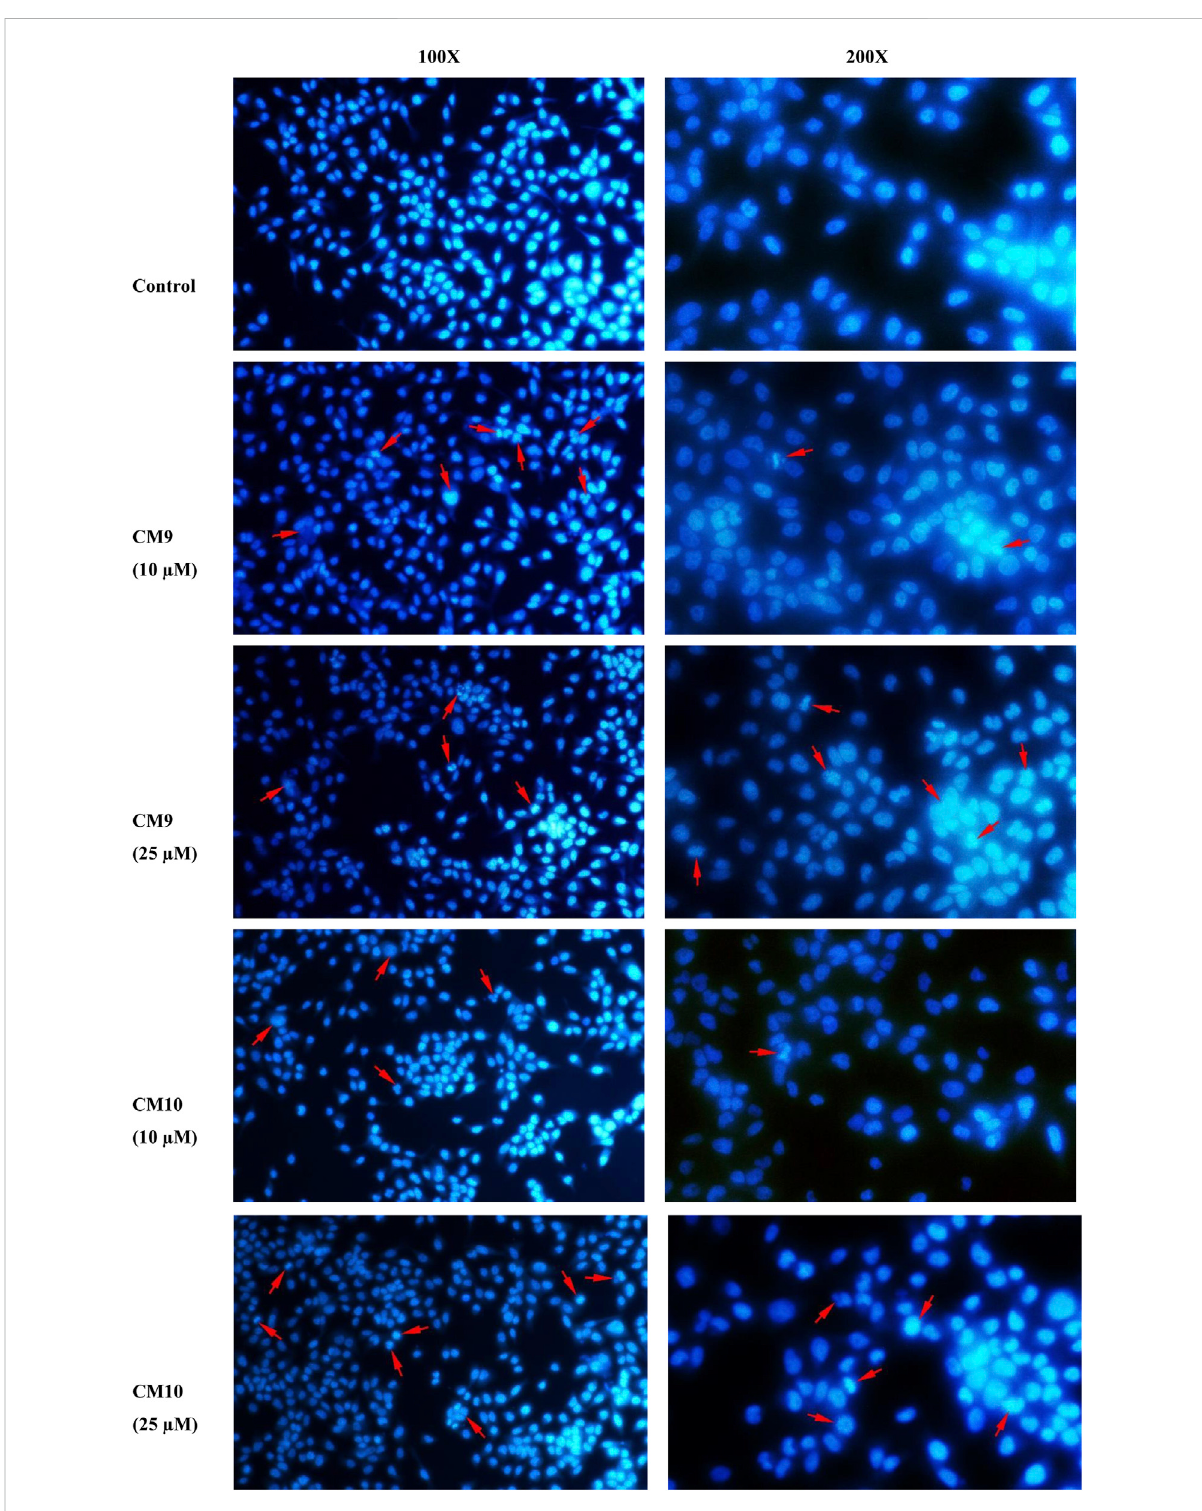
FIGURE 5 Apoptosis induction measurement by Hoechst 33258 staining assay. EBC-1 cells were seeded in 6-well plates and treated with different concentrations of test compounds for 72 h. After fi xation with 4% cold paraformaldehyde (PFA) the cells were stained with 2.5 μ g/ml Hoechst 33258 and imaged with a fl uorescence microscope (Mag: 100X and 200X). A representative image is shown for each compound. Red arrows show apoptotic